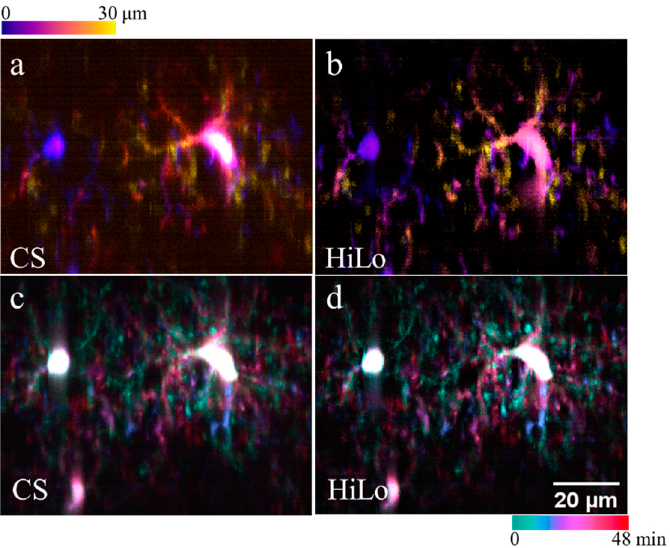
Figure 5. Dynamical imaging of microglia cells in CX3CR1-GFP mouse brains. The whole recording time is 48 min over a volume of 30 µ m thickness. ( a , b ) Depth color coded stacks based on CS and HiLo methods, respectively. ( c , d ) Temporal color-coded maximum-intensity-projections (along axial directions of the image stacks) based on CS and HiLo methods, respectively.